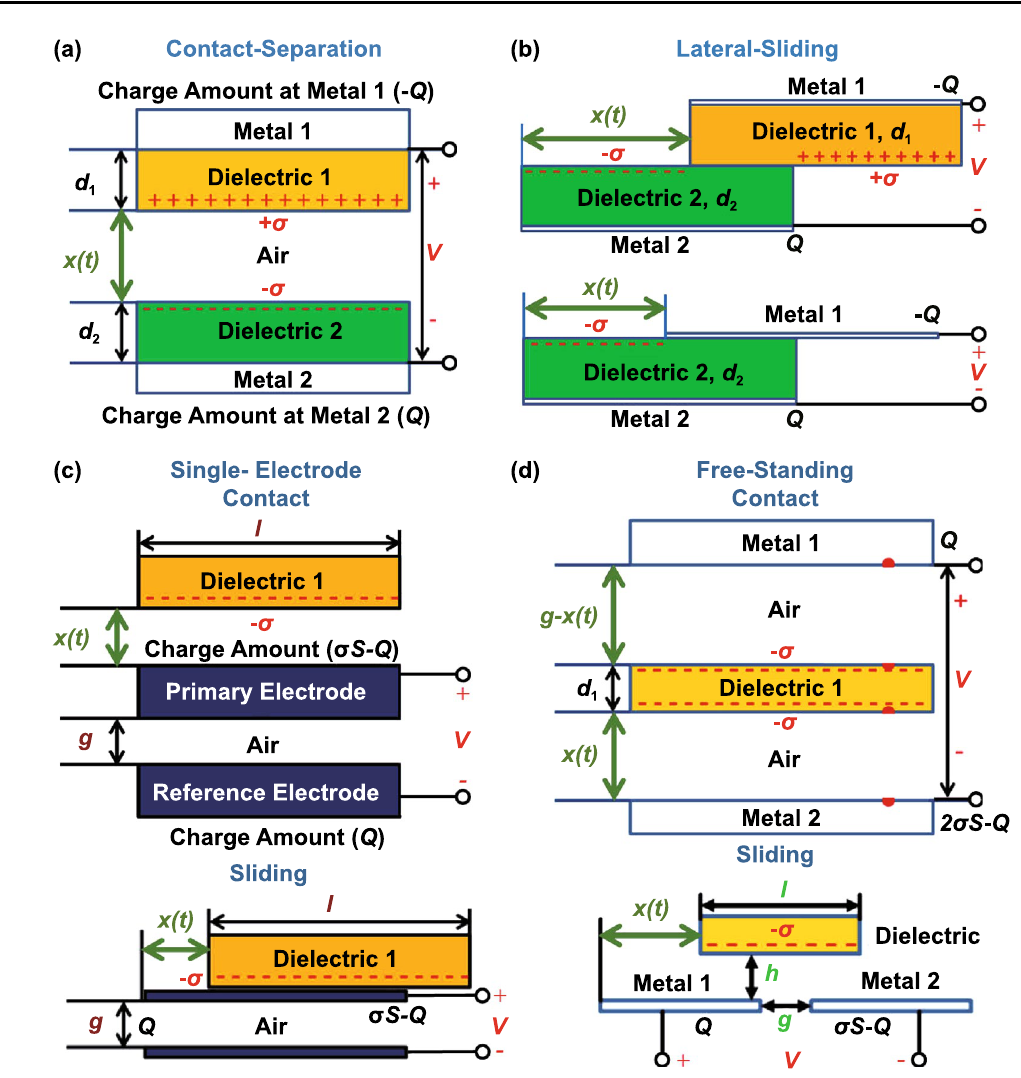
Fig. 3 Transduction mechanism models for the four modes of operation of TENGs: a Contact-separation [131]. b Lateral-sliding (dielectric- dielectric on top and metal-dielectric on bottom) [132]. c Single-electrode (contact-mode on top and sliding-mode on bottom) [133]. d Contact free-standing mode (contact-mode on top and sliding-mode on bottom) [134]. Mechanically induced time variations of the distance ( t ) between charged triboelectric layers results in a voltage ( V ) build-up and balancing flow of free charges ( Q ) through an external circuit. Adapted from Ref. [1]. (Color figure